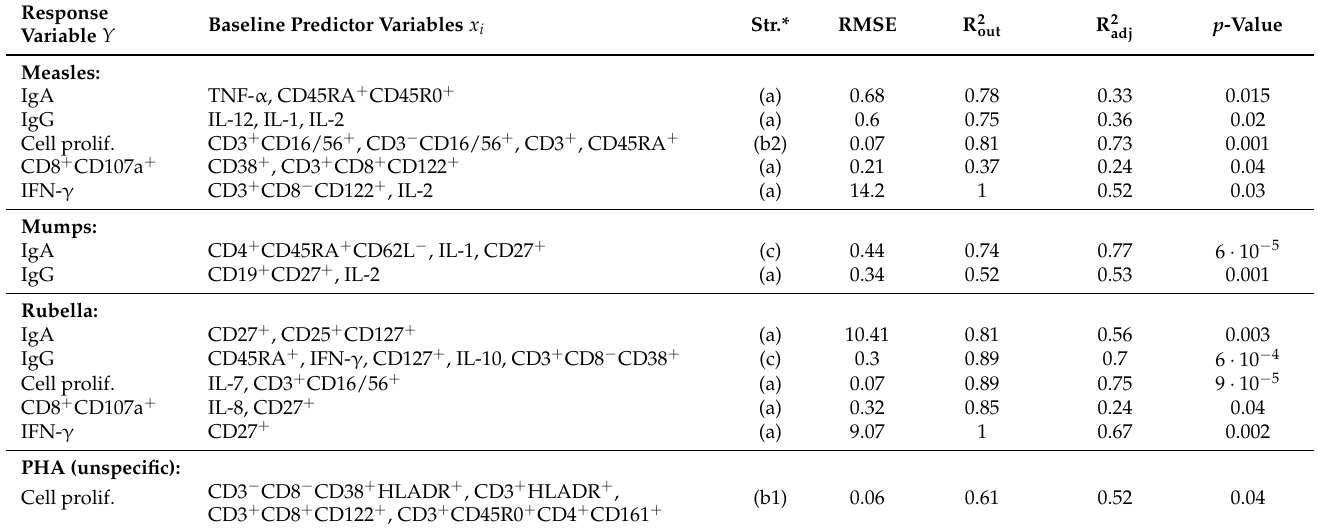
Table 1. Summary of the final multilinear regression models predicting post-vaccination immune response variables: baseline predictor variables, cross-validation-based consistency metrics (mean out-of-sample error (RMSE), coefficient of determination ( R 2 )), model performance fitted on the out complete dataset (adjusted R 2 , F-test p -value). adj